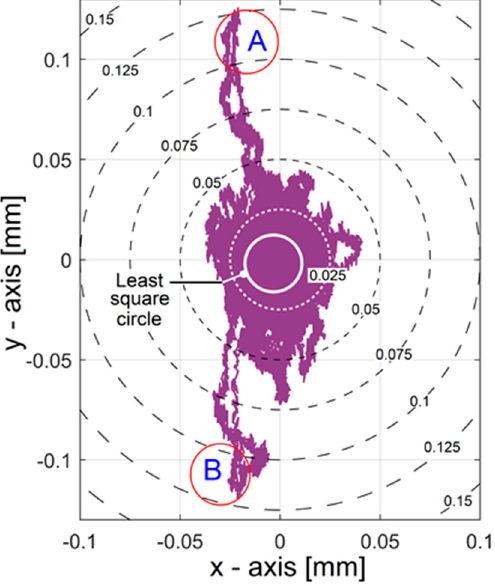
Figure 18. The evolution of the average trajectory generated by x Ar and y Ar . The least square circle (14.2 µ m radius, with center at x c = − 3.3 µ m and y c = − 1.9 µ